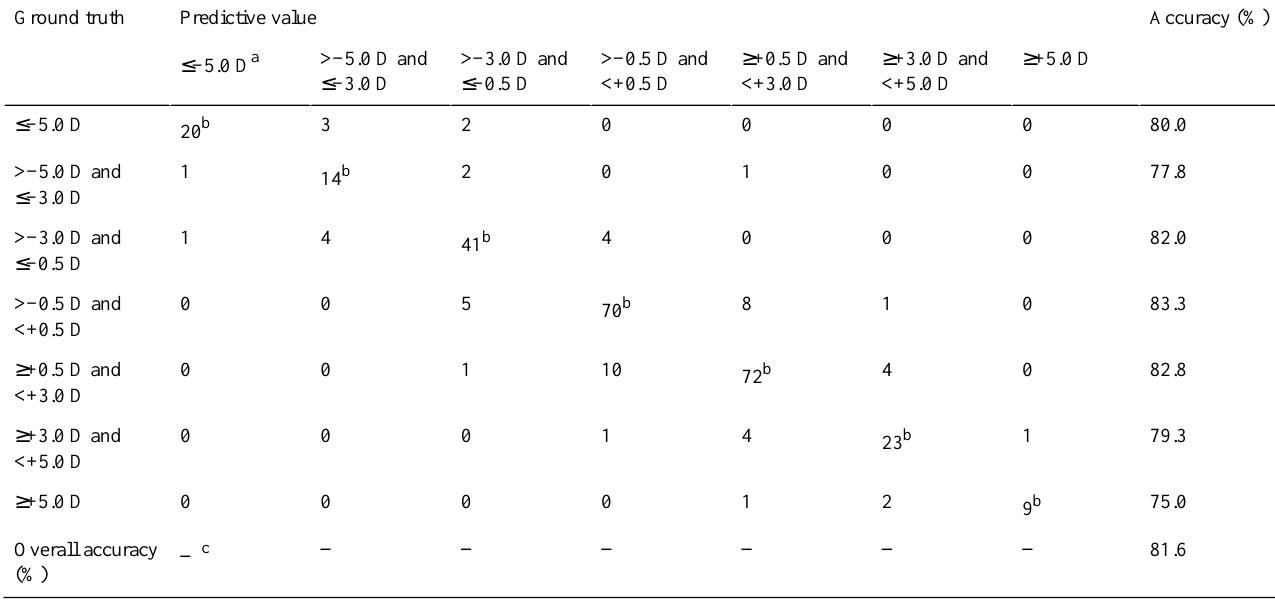
Table 5. Confusion matrix for refractive error classification of our deep convolutional neural network.